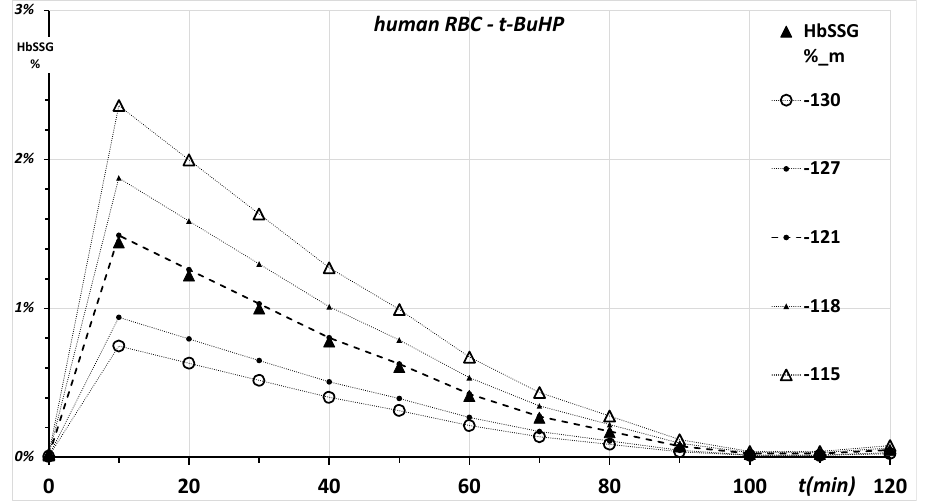
Figure 2. Equilibrium concentrations of glutathionyl-hemoglobin (HbSSG%) calculated according to the Nernst equation. The E h redox potentials correspond to those of the GSSG/GSH redox couple calculated according to the concentrations of GSH and GSSG measured during the experiment. Different estimates of E 0 for the HbS/HbSH couple are used to derive the concentration ratio dependent term of the Nernst equation for HbSSG/HbSH. For clarity, only two values for higher and two for lower E 0 of the HbS/HbSH couple are reported.